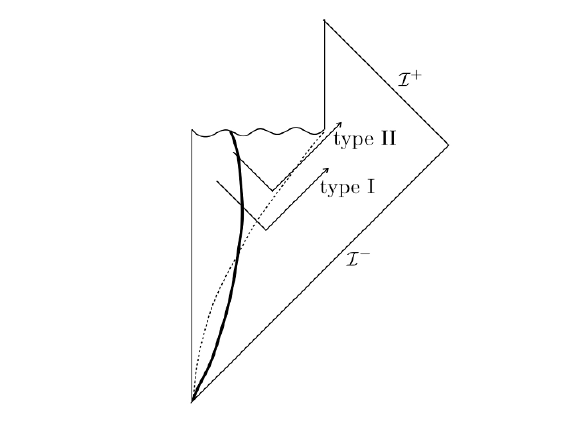
Figure 2 . Typical Penrose diagram of the supertranslated Vaidya black hole at a fixed value of Θ A . The dashed line represents the FOTH r = r h , the wavy line represents the singularity r = 0 and the thick curve represents a collapsing